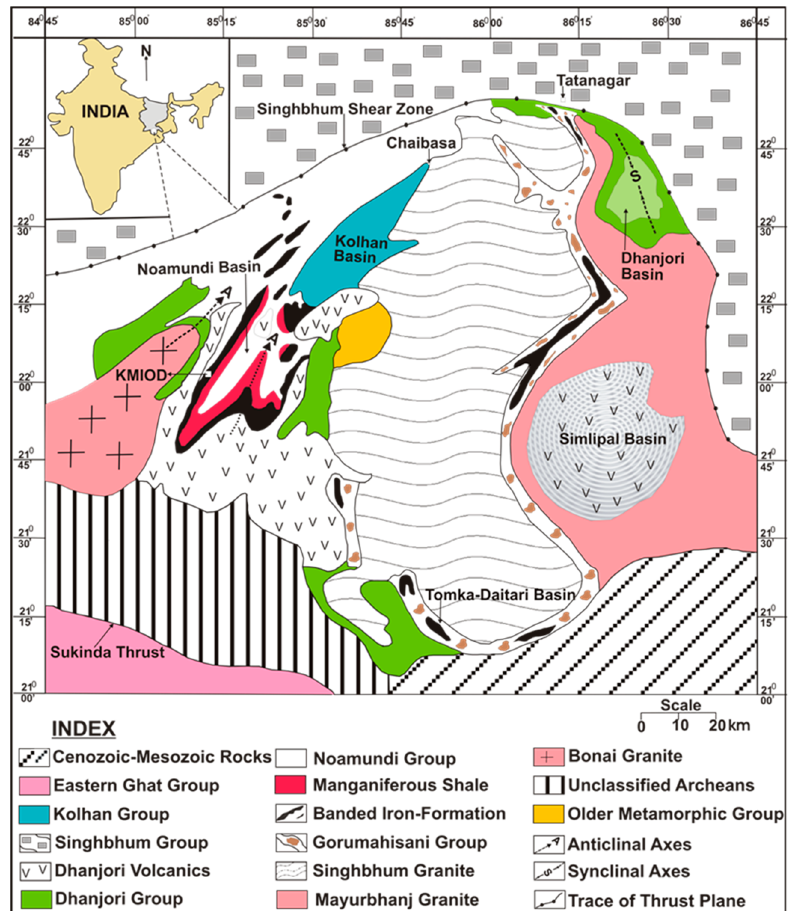
Figure 1. Geological map of Singhbhum-Orissa iron ore craton showing distribution of different lithological units. The study area Kiriburu-Meghahatuburu iron ore deposit (KMIOD) forms part of western limb of horse-shoe synclinorium modified after [10,11].